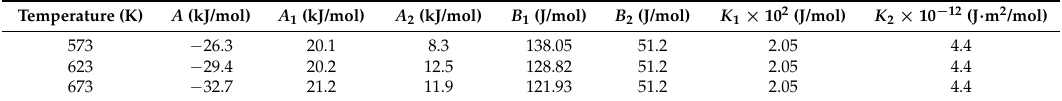
Table 1. Table 1. Values of the parameters in the function of local free energy. Table 1. Values of the parameters in the function of local free energy.